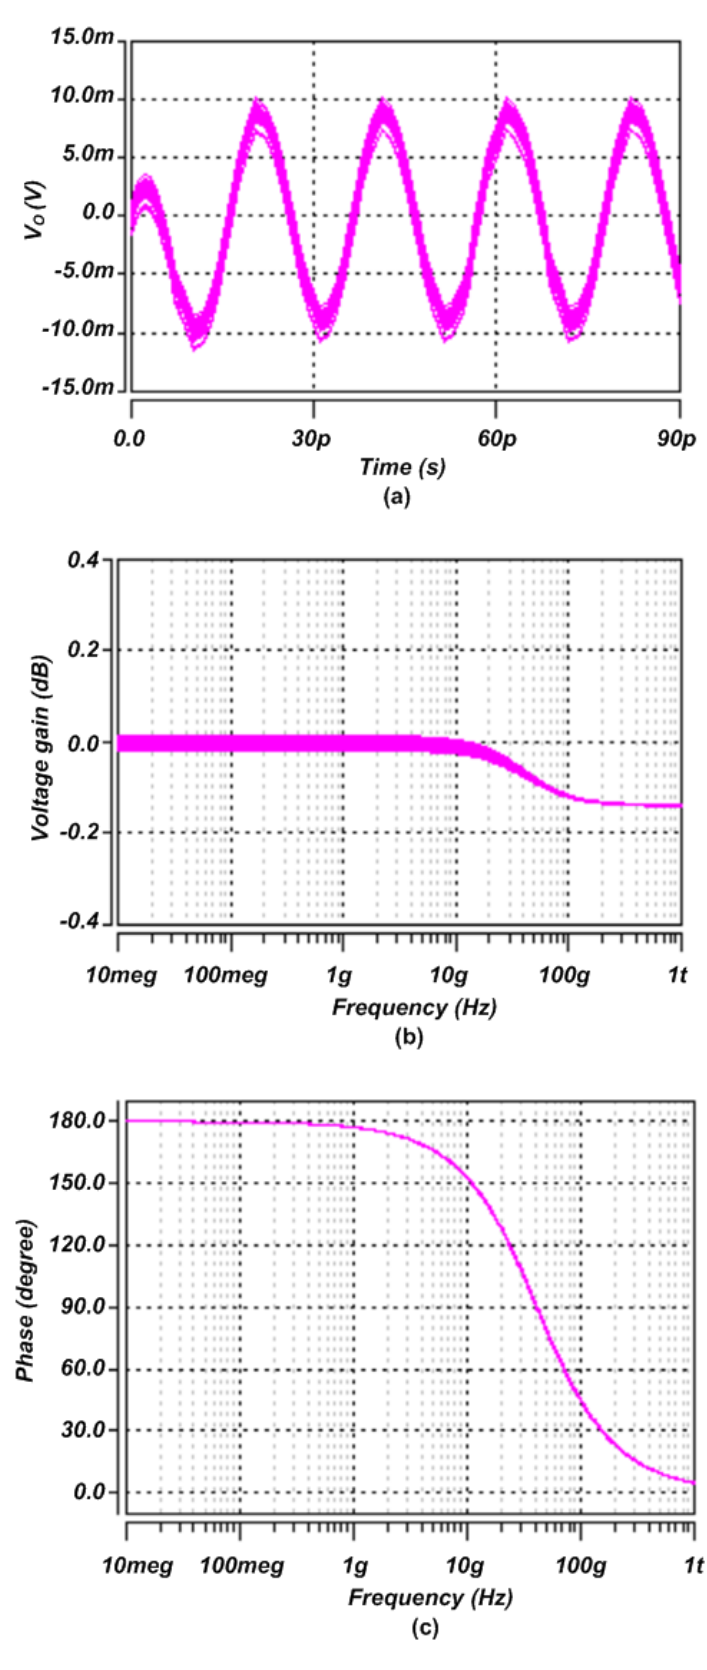
Figure 13. Monte Carlo simulations of AOTAPF for: ( a ) Time domain; ( b ) Voltage-gain ( V o / V i ); ( c )